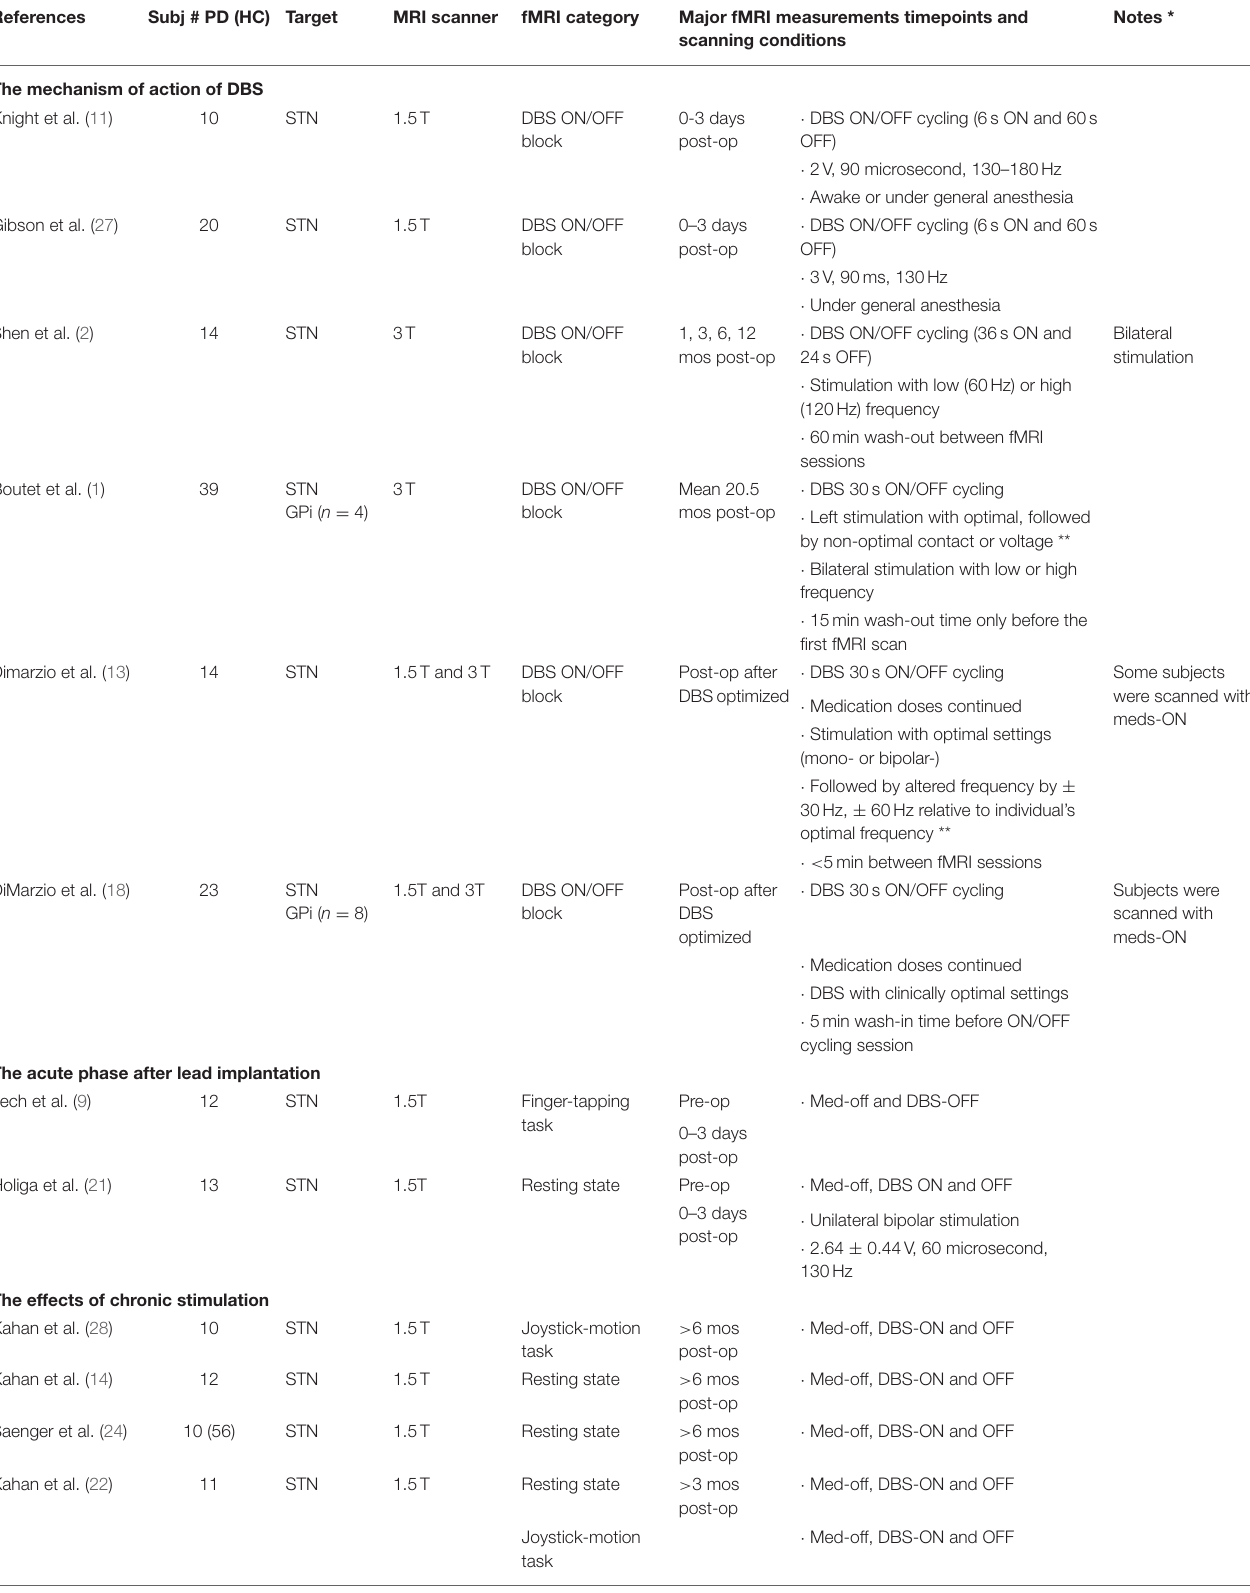
TABLE 2 | Summary of included articles for qualitative